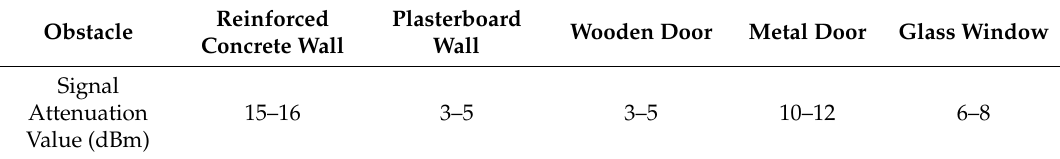
Table 1. Signal attenuation through di ff erent